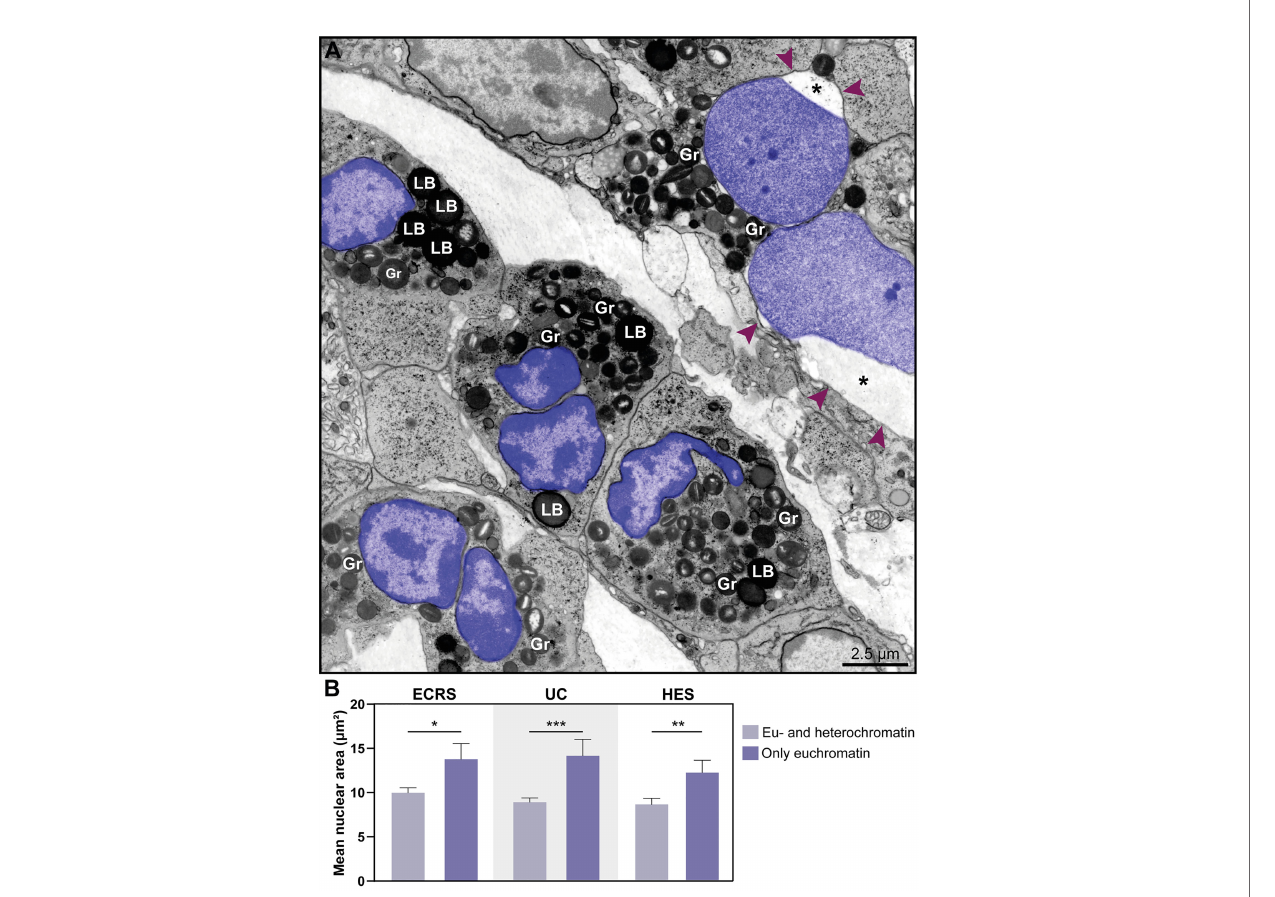
FIGURE 5 | The nuclear area increases in eosinophil undergoing ETosis. (A) A cluster of tissue eosinophils in fi ltrated in the skin of a patient with hypereosinophilic syndrome (HES). While several intact eosinophils show nuclei with normal chromatin appearance (marginal heterochromatin and more internal euchromatin), an early ETotic eosinophil (upper right side) shows enlarged decondensed nucleus undergoing delobulation and rounding. Note that the nuclear space (*) of the nuclear envelope is dilated with separation of the external membrane (arrowheads) from the internal one. All eosinophil nuclei were colored in purple. In (B) , quantitative analyses reveal signi fi cantly higher nuclear area in eosinophils in early ETosis (only euchromatin) compared to eosinophils with euchromatin/heterochromatin distinction. A total of 263 eosinophils [77 for eosinophilic chronic rhinosinusitis (ECRS), 120 for ulcerative colitis (UC), and 68 for HES] were evaluated and the nuclear area (μm²) measured. Samples were collected from patients with ECRS (n=2), UC (n=16), and HES (n=2) and prepared for TEM. Results are expressed as means ± SEM (* P < 0.05; *** P < 0.01; *** P < 0.001). Gr, secretory granules; LB, lipid